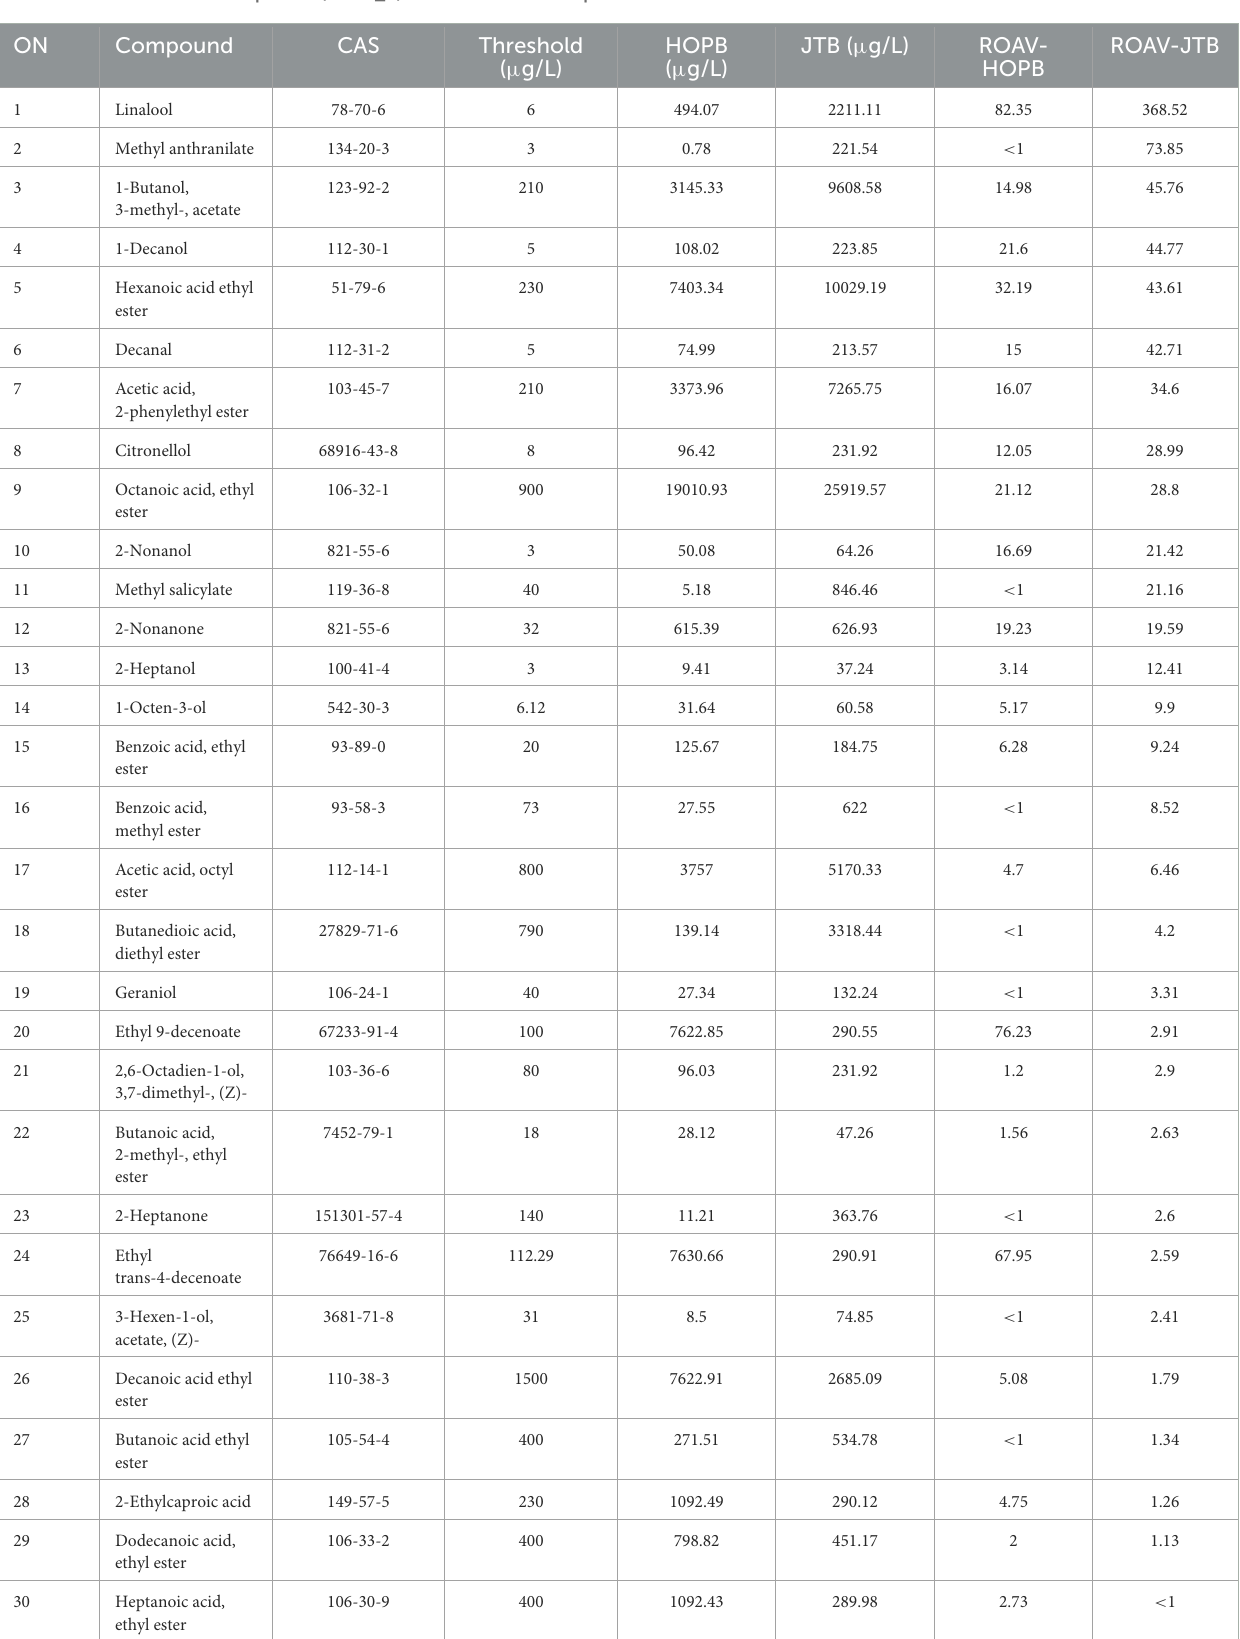
TABLE 3 Main odor-active compounds (ROVA ≥ 1) in HOPB and JTB